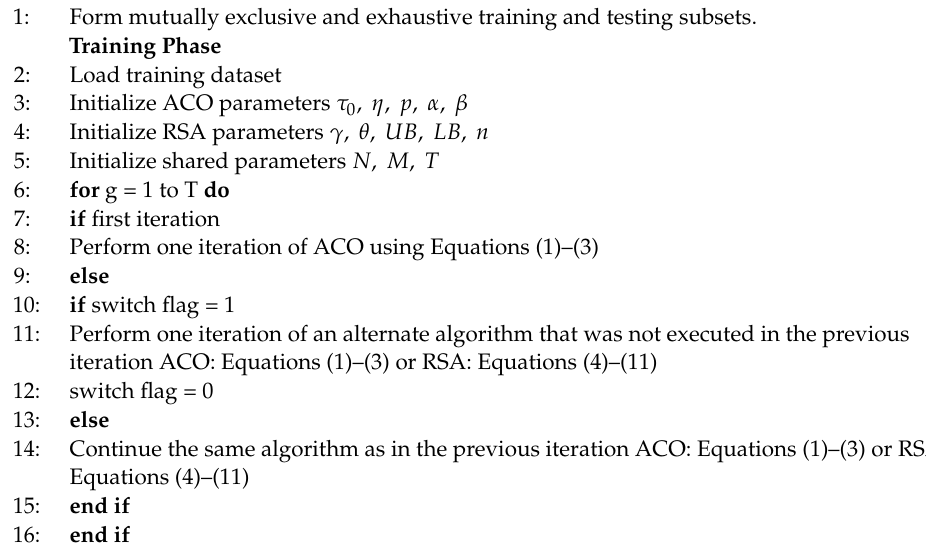
Algorithm 1: Proposed ACO-RSA